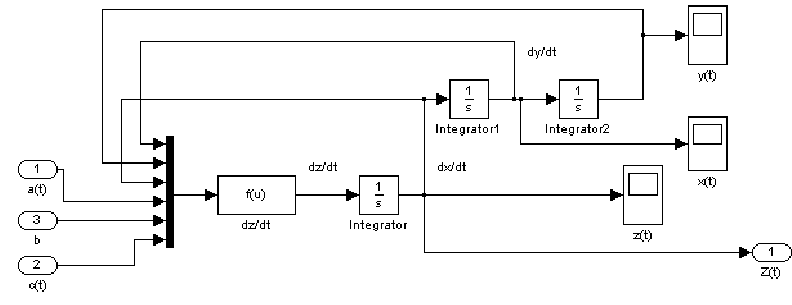
Figure 3. MATLAB/Simulink model of the transmitter block.